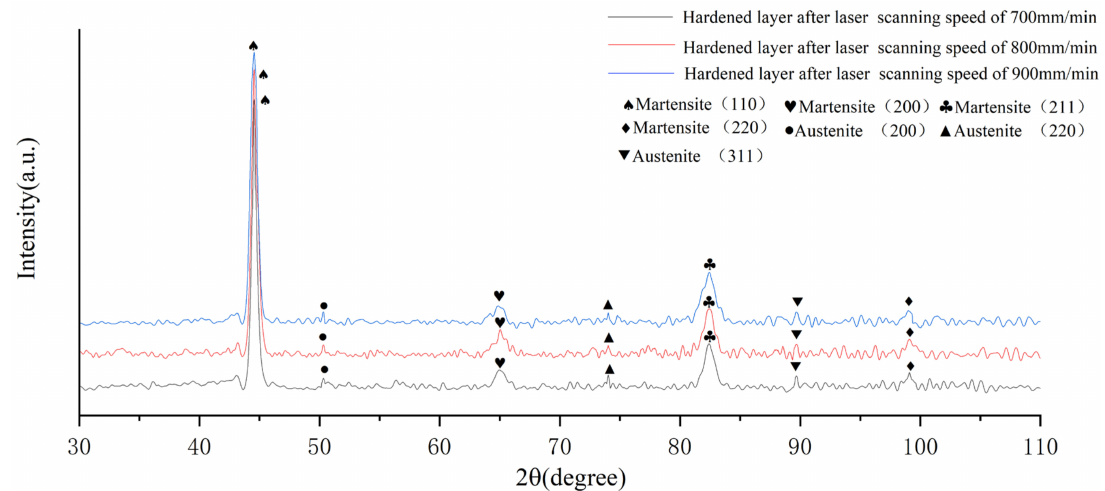
Figure 15. X-ray diffraction plot of hardened layer at a scanning speed of 700 mm/min, 800 mm/min, and 900 mm/min.